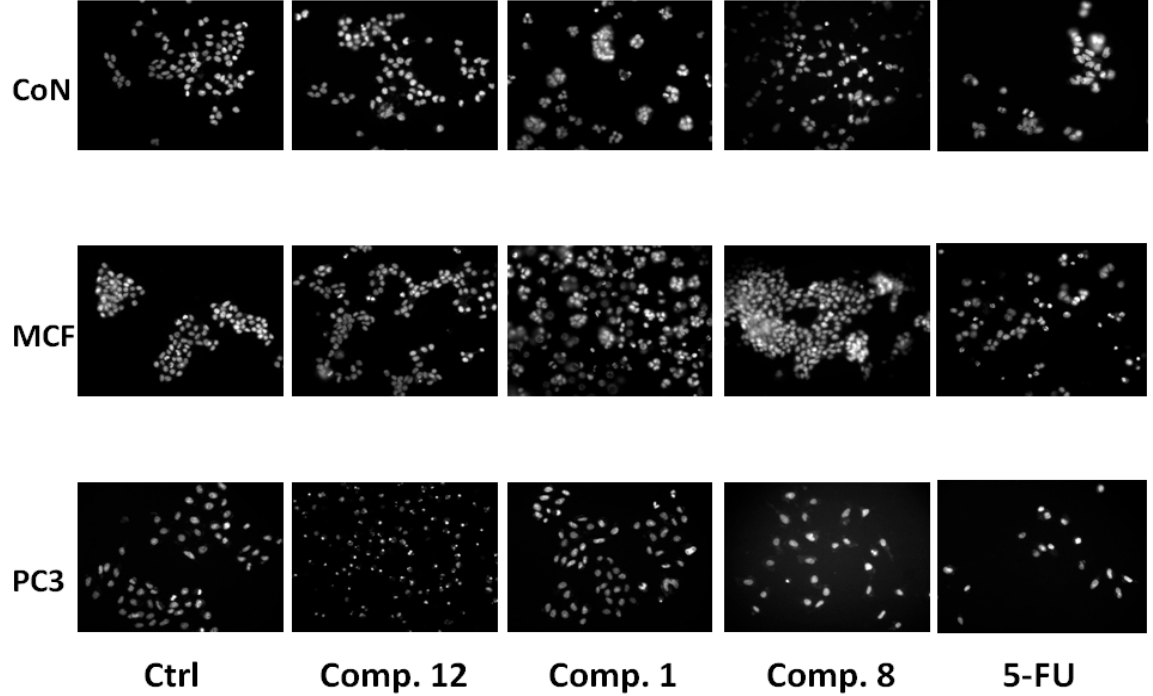
Figure 4. Effect of compounds 1 , 8 and 12 on chromatin condensation and fragmentation. CoN, MCF-7 and PC-3 cells treated with one of the compounds were stained with Hoechst 33342 (200×). Representative photographs presented here show nuclear morphologic changes observed by fluorescent microscopy of the treated cells. As positive control, 5-fluorouracyl (25 μ M) was